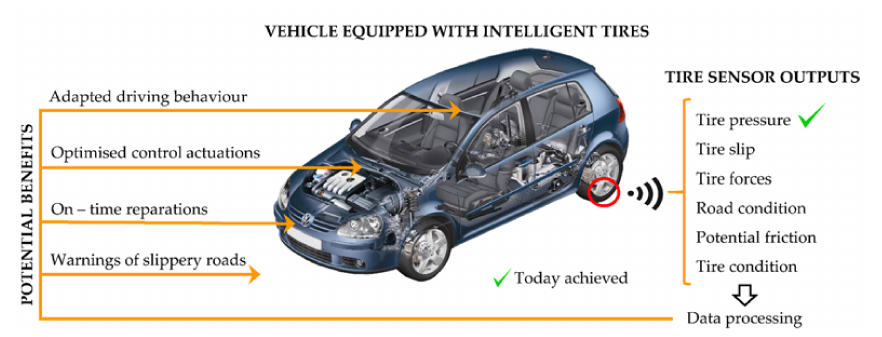
Figure 1. Intelligent tire’s potential benefits [2,3].